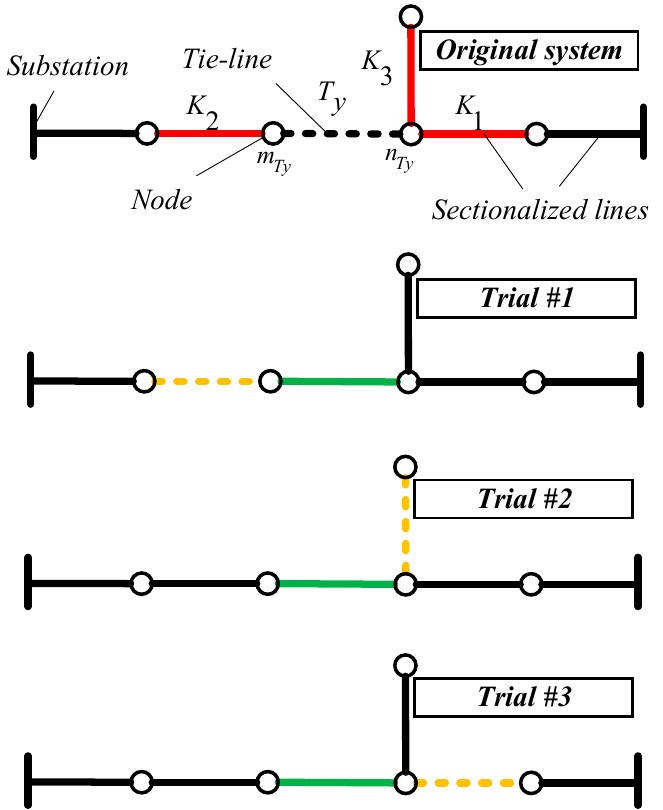
Figure 2. Possible trails to exchange the tie-line T y with its neighboring lines, including K 1 , K 2 , and K 3